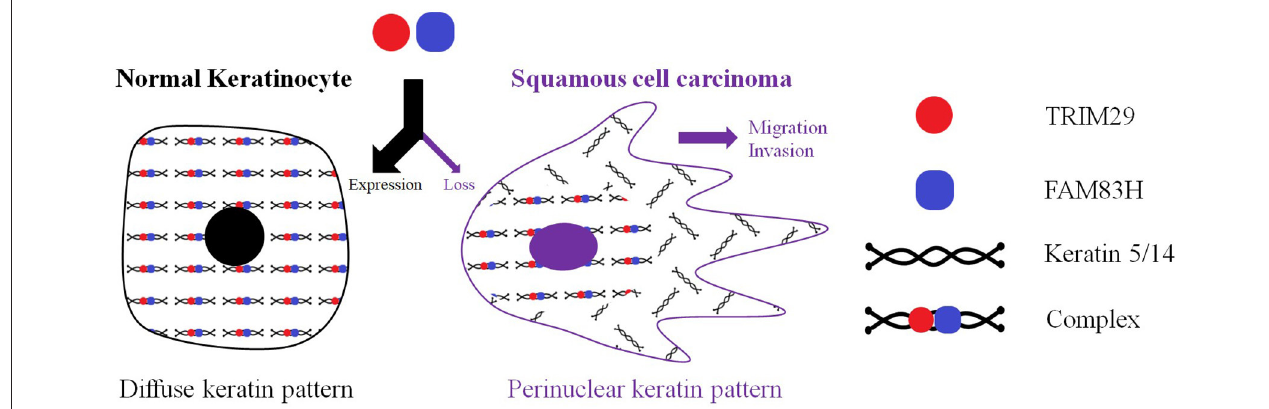
FIGURE 3 | TRIM29 was proven to colocalize with keratin 5, keratin 14, and FAM83H in the cytosol, and to form the TRIM29–keratin–FAM83H complex. FAM83H and TRIM29 can be characterized as sharing similar features in regulating keratin distribution and cell migration. The TRIM29–keratin–FAM83H complex is thought to regulate the keratin distribution in cutaneous